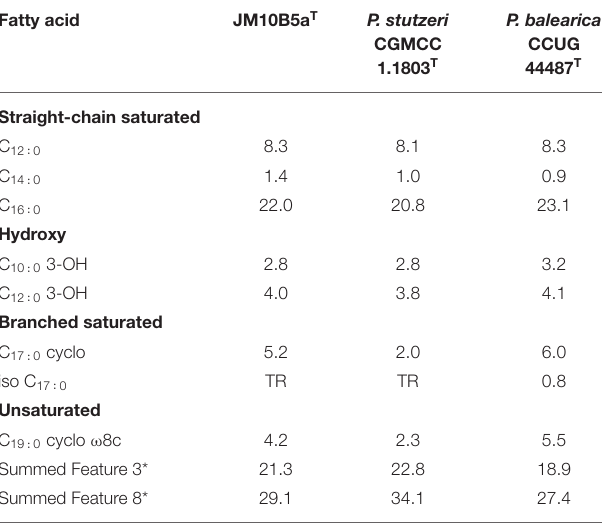
TABLE 2 | Differential characteristics of strain JM10B5a T and the closely related type strains of genus Pseudomonas .